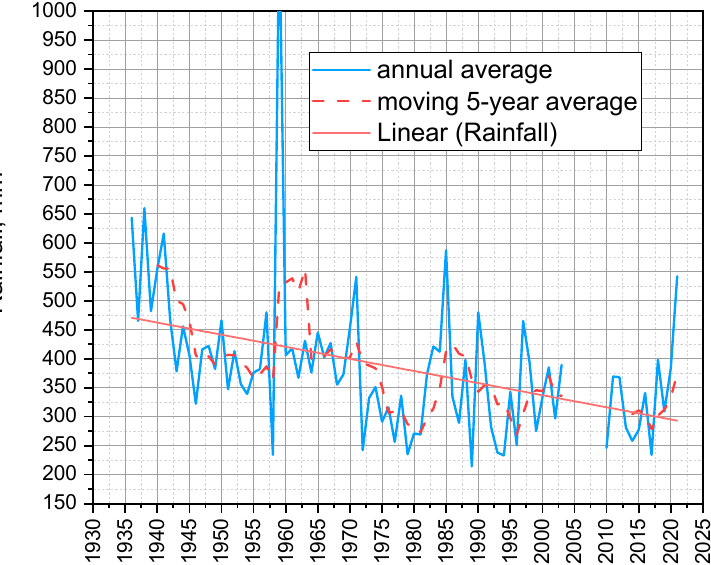
Figure 5. Rainfall trend at the Kabansk station for the period of 1936–2021. The plot of precipitation recorded at Kabansk station from 1936 to 2021 shows a slight downward trend, which is consistent with the SS and MK data.